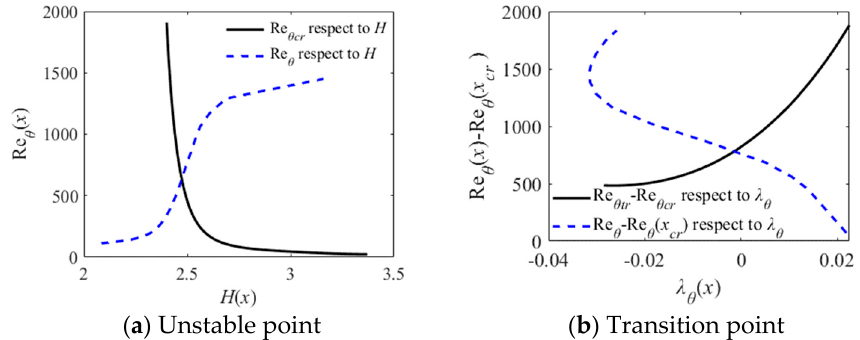
Figure 3. The Granville method to determine the unstable point and the transition point.